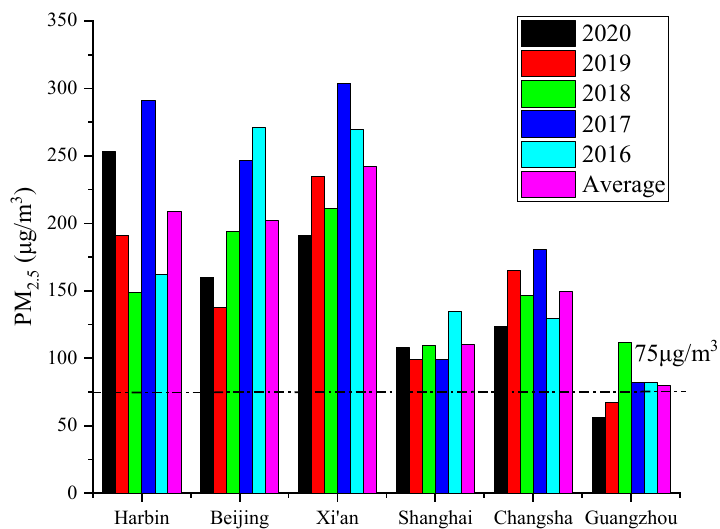
Figure 2. The outdoor concentration value corresponding to no-guarantee for 5 days.